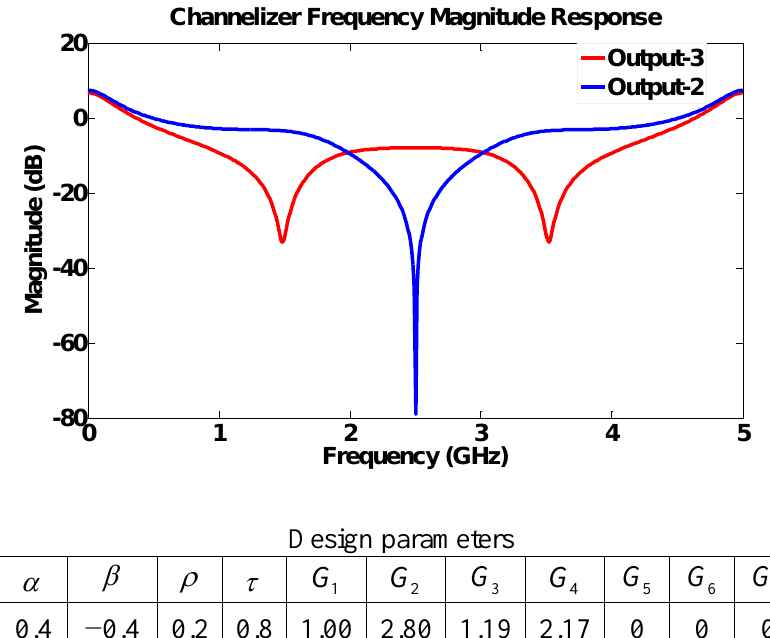
Figure 15. Frequency response for structure IV using high transmission parameters with different combination of unused